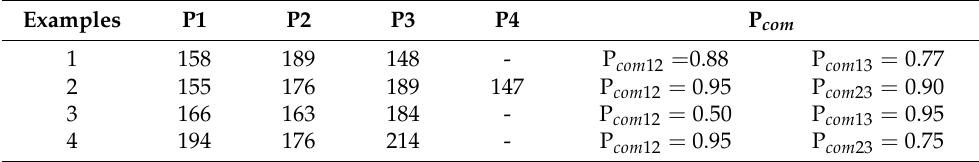
Table 3. Confidence and proximity scores of parcels.